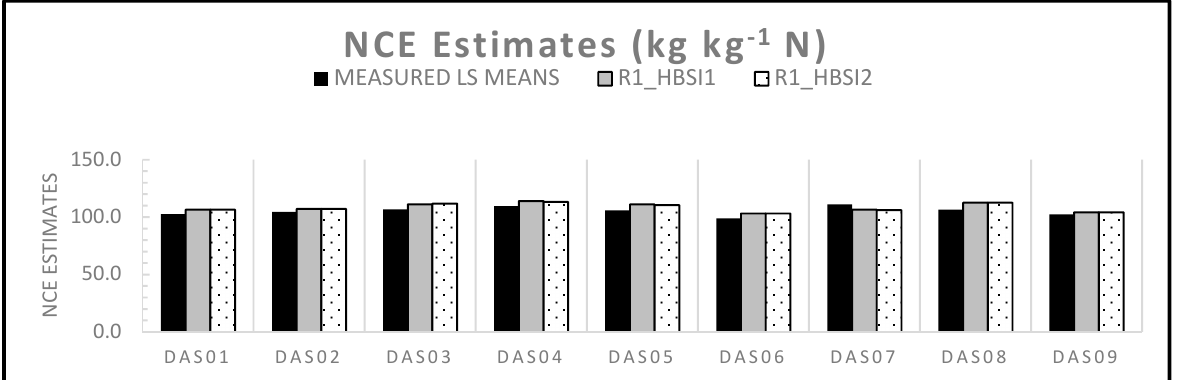
Figure 5. Least square means estimates of NCE by hybrid based on measured or HSI models.